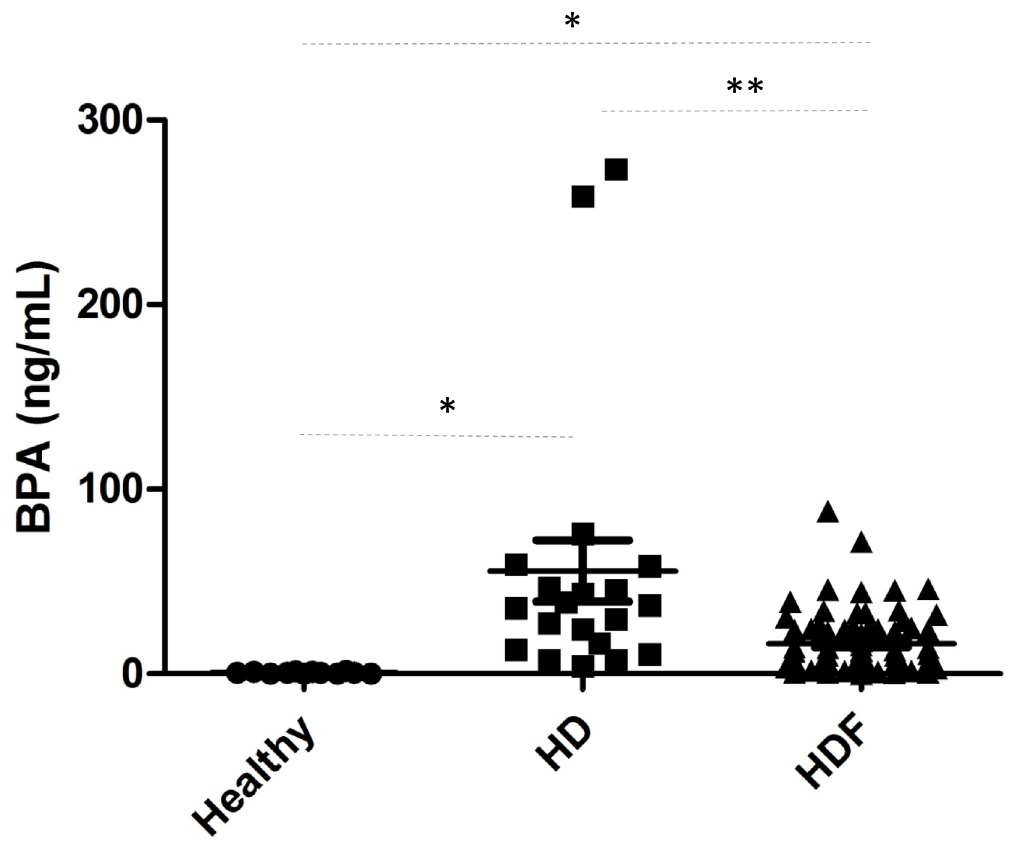
Fig 3. Plasma BPA concentration. Healthy subjects (n = 10); patients on online hemodiafiltration (HDF) (n = 58) and patients on conventional hemodialysis (HD) who were later enrolled in the present study (n = 18) [7]. Data expressed as mean ± SD. For HD and OL-HDF, values correspond to baseline predialysis values in the switch studies. At this point, patients had been on HD or OL-HDF for > 6 months. (cid:3) p < 0.05; (cid:3)(cid:3) p =